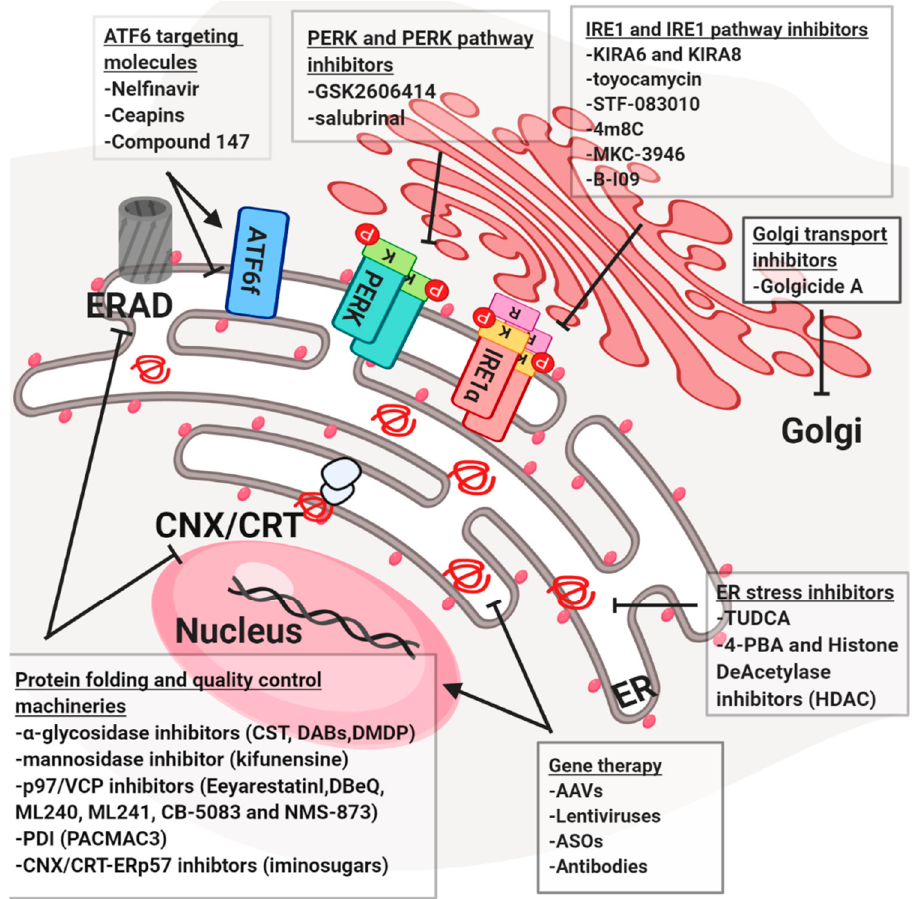
Figure 4. Targeting different steps in the early secretory pathway. Schematic presentation of proteostasis targeting compounds used in clinic for the treatment of diverse diseases.